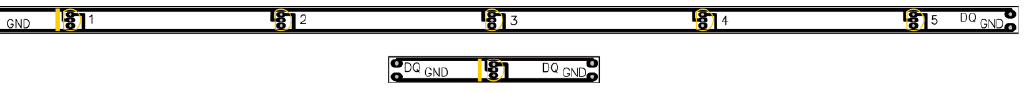
Figure 4. PCB modules for sensors.